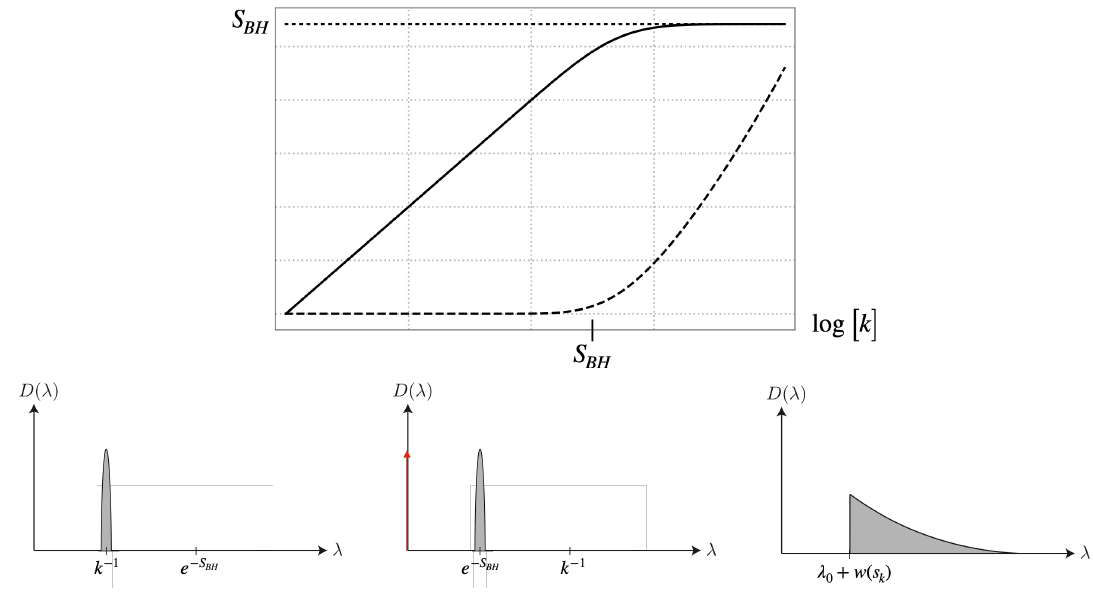
Figure 6 . Top: the relative entropy between pure states in the code subspace (dashed line) is shown alongside the von Neumann entropy (solid line) and black hole entropy (dotted line) using the approximate entanglement spectrum eq. (3.19). Unlike the microcanonical ensemble, the relative entropy is smooth and finite across the Page transition. It grows unboundedly as (log k ) 2 at large k . Bottom: we sketch the spectrum of ρ Rad prior to the Page time (left) after the Page time in the microcanonical ensemble (middle) and after the Page time in the canonical ensemble (right). The red arrow indicates an delta function at